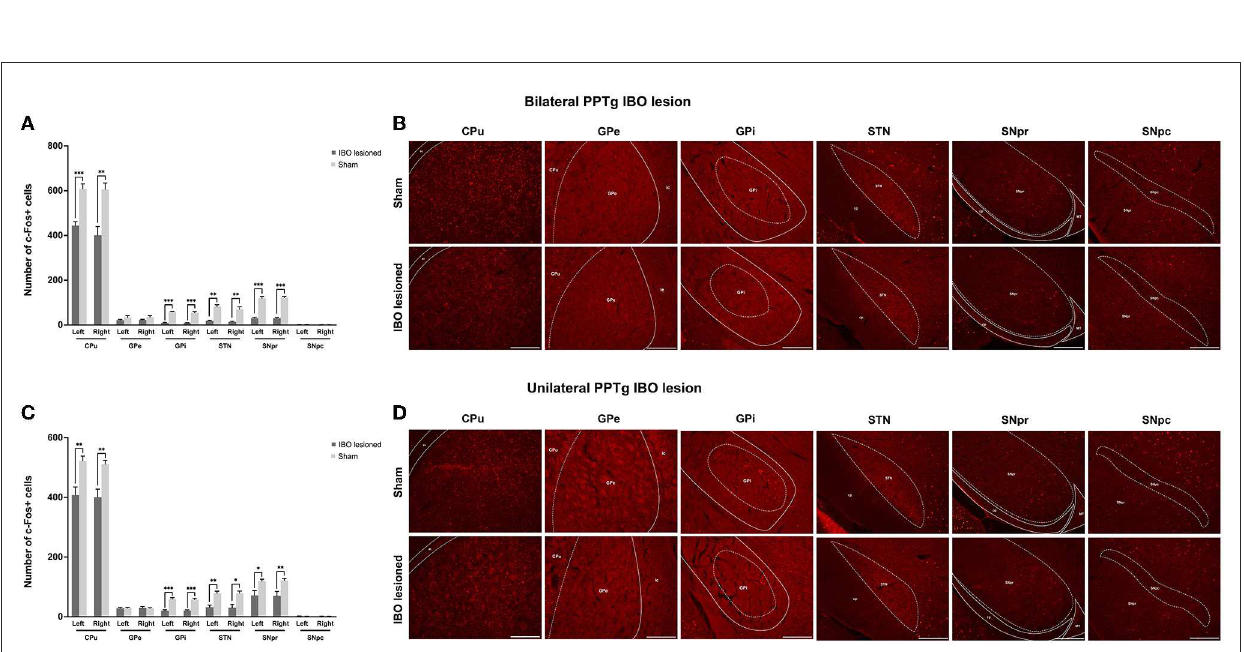
FIGURE9 Alterations of the neural activity in the BG following the PPTg IBO lesion. (A) Significantly reduced neural activity was found in the dorsolateral part of the CPu, GPi, STN, and SNpr, while no change was observed for the GPe and SNpc after the bilateral lesion. (B) representative photographs of c-Fos + cells in the dorsolateral part of the right CPu, GPi, STN, SNpr, and SNpc following the bilateral lesion. (C) Significantly reduced neural activity was found in the dorsolateral part of the CPu, GPi, STN, and SNpr, while no change was observed for the GPe and SNpc after the unilateral lesion. (D) Representative photographs of c-Fos + cells in the dorsolateral part of the right CPu, GPe, GPi, STN, SNpr, and SNpc following the unilateral lesion. * P < 0.05, ** P < 0.01, *** P < 0.001. Scale bar = 1000 µ